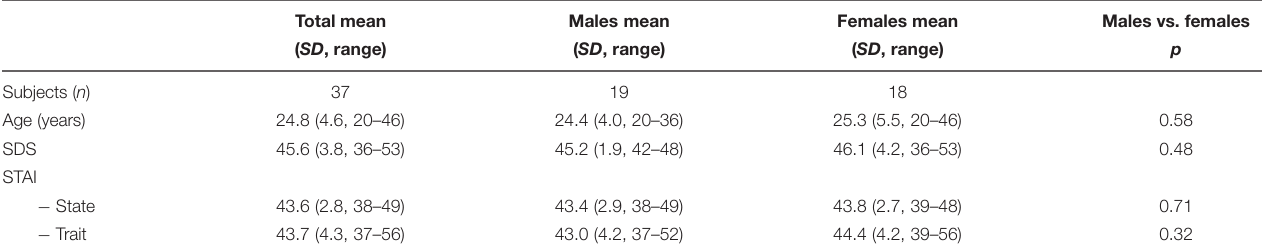
TABLE 1 | Demographic and psychometric data of the subjects.